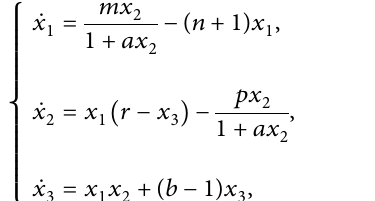
Figure 2: The influence of uncertain factors on system (1). (a) Time series with different initial values. (b) Errors of each